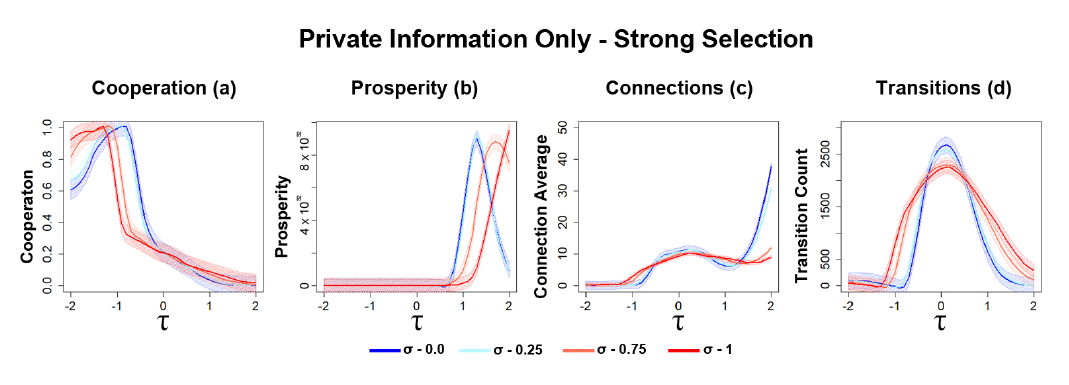
Figure 7. Transitions are more frequent in the case of strong selection when only private information is used. The plots visualise and compare the metrics of cooperation, prosperity, average connectivity and number of transitions observed in networks that utilise differing levels of opinion diversity. Although there are some similarities with Figure 6 for how increasing σ can affect cooperation, strong selection clearly leads to an increase in transitions. Networks here struggled to engage in long term cooperation for higher values of τ . Data obtained by running the model for 10 8 steps with only private information and a δ setting of 0.1. τ represents the decision threshold. σ represents opinion diversity. Shading represents level of standard error calculated for each dataset. Data interpolated utilising RStudio [22]. Plots produced via RStudio utilising code found in Appendix